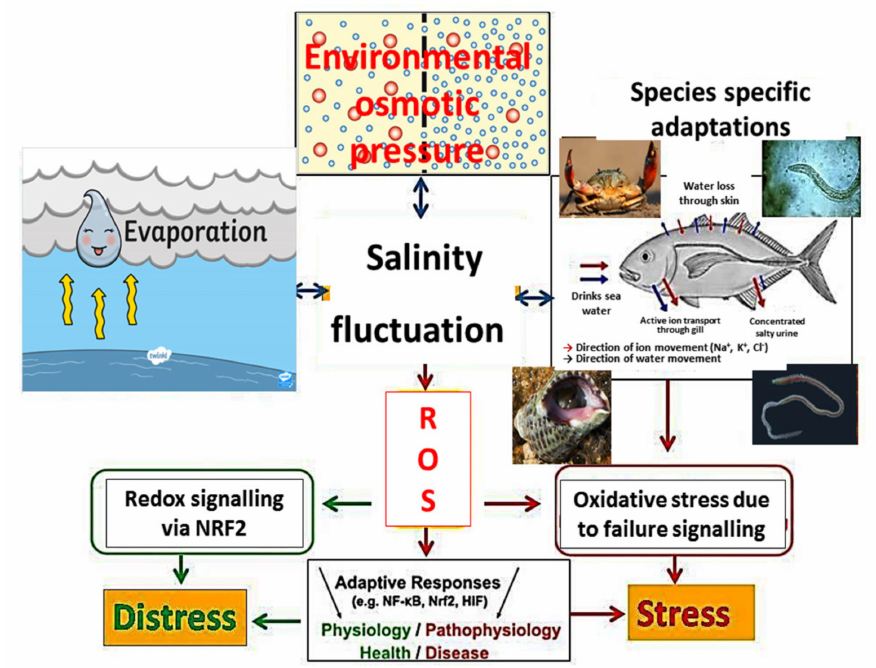
Figure 9. Redox regulation under salinity stress in animals: Low or high salinity can induce oxidative stress in aquatic animals, mainly due to the lower activity levels of the redox-regulatory